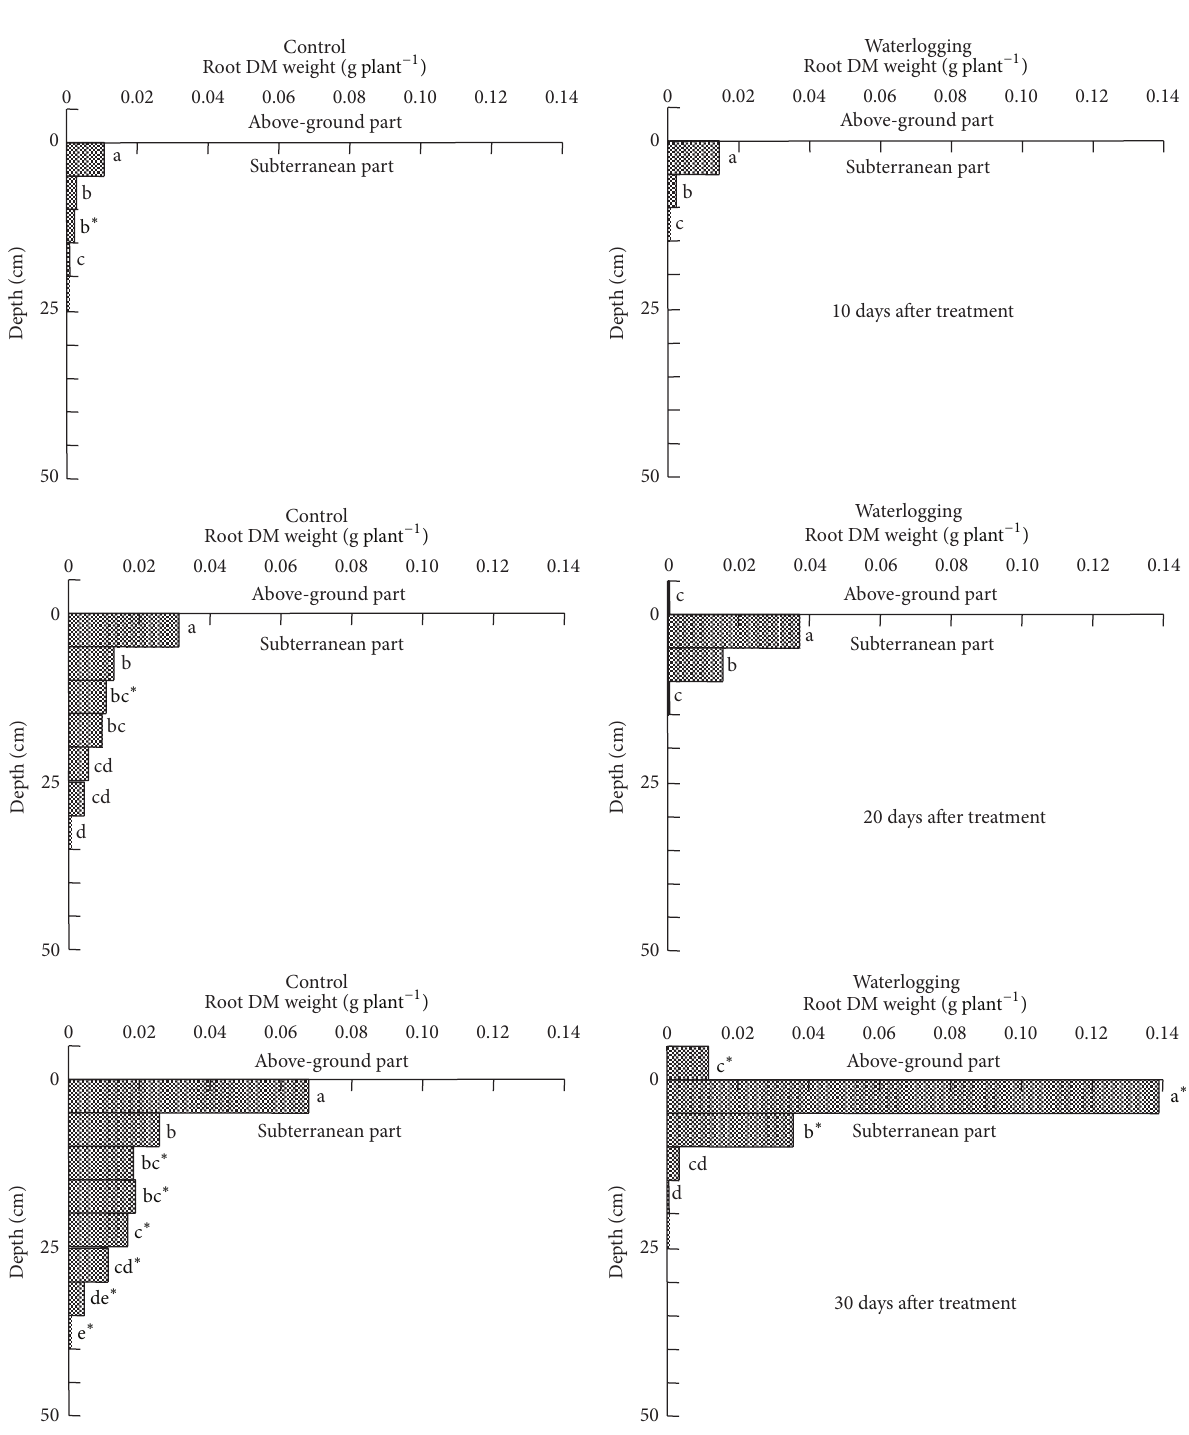
Figure 1: Distribution of roots from 10 to 30 days after treatment in experiment 1. Symbols with different letters within the same investigation date and treatment show significant differences ( 𝑃 < 0.05 ). ∗ Significantly different ( 𝑃 < 0.05 ) between control and waterlogging treatment with the same root